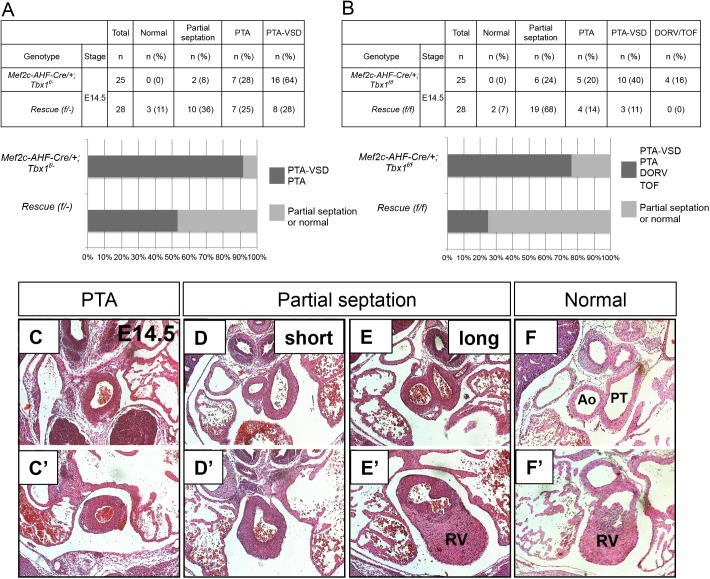
Phenotype analysis of significantly rescued Tbx1 LOF embryos.Phenotypes in embryos in which one β-catenin loss of function allele to either Mef2c-AHF-Cre/+;Tbx1f/- embryos (A) or to Mef2c-AHF-Cre/+;Tbx1f/f embryos (B) was done to lower the dosage of β-catenin within the AHF. Significant rescue (p < 0.001, Fisher’s exact test) was obtained in both sets of double mutant embryos. Middle panels show the percent within the groups with PTA (C and C’), DORVor TOF associated with a VSD or PTA without VSD (dark grey) and those ones with partial septation or a normal heart (light grey). Partial septation in Tbx1 LOF embryos means a PTA with presence of a short septum at some level of the OFT (D and D’) and complete septation between the ventricles (8/50) while partial septation in the rescue genotype embryos (34/56) means a range of noticeably less severe phenotypes including: a longer partial OFT septation (E and E’) and either complete septation between ventricles (15/56) or VSD (10/56) or normal OFT (F and F’) with a VSD (4/56) or normal heart [5/56] (F and F’). Abbreviations: aorta (Ao), pulmonary trunk (PT), right ventricle (RV), outflow tract (OFT), PTA (persistent truncus arteriosus).